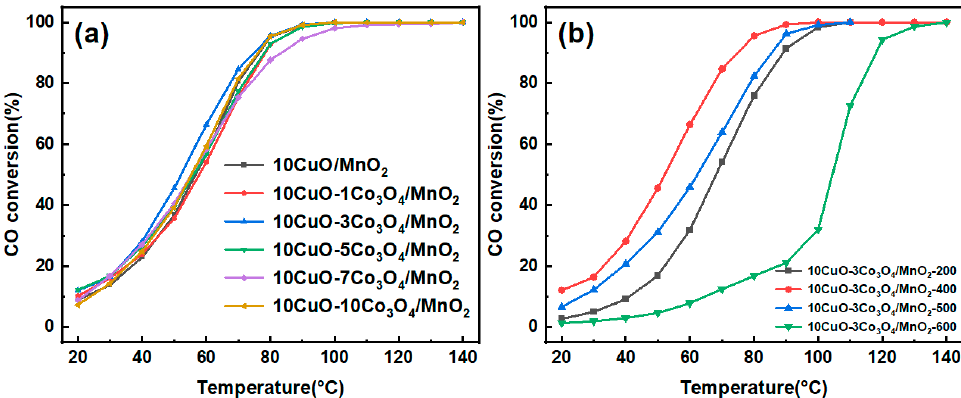
Figure 8. CO conversions over the ( a ) 10CuO-yCo 3 O 4 / α -MnO 2 -400 (y = 0, 1, 3, 5, 7, 10), and ( b ) 10CuO-3Co 3 O 4 / α -MnO 2 -T (T = 200, 400, 500, 600 °C) catalysts under the reaction conditions: ( b ) 10CuO-3Co 3 O 4 / α -MnO 2 -T (T = 200, 400, 500, 600 ◦ C) catalysts under the reaction conditions: CO/O 2 /N 2 = 1/20/79, GHSV = 12,000 mL·g − 1 ·h − 1 , 1 atm. CO/O 2 /N 2 = 1/20/79, GHSV = 12,000 mL · g − 1 · h − 1 , 1